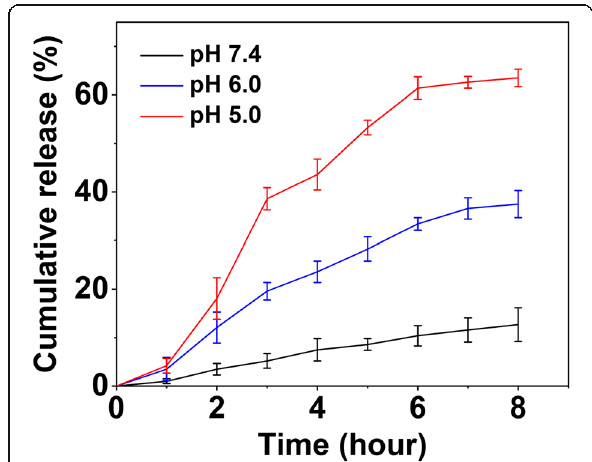
Fig. 2 In vitro DOX release profile of DOX-CDs at pH 5.0, 6.0, and 7.4